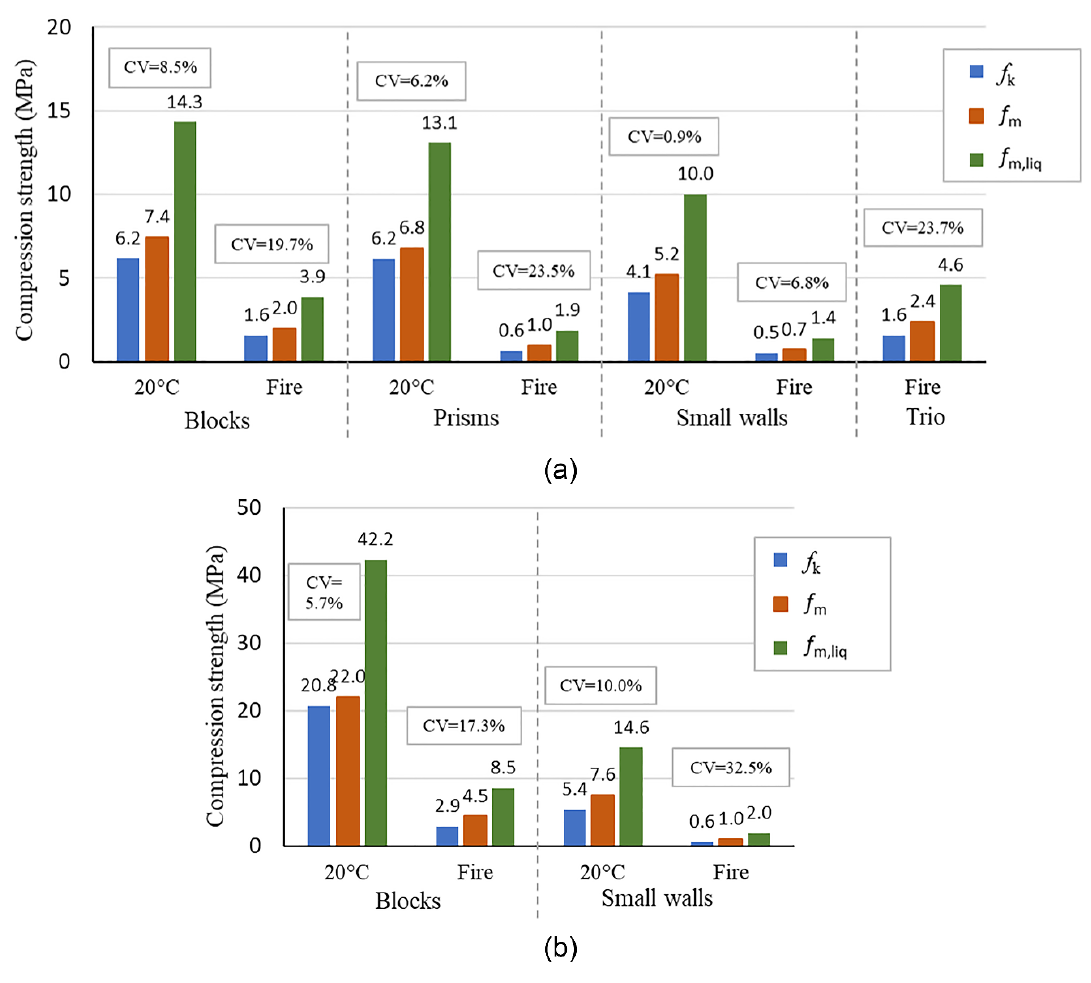
Figure 12. Compressive strength before and after fire: (a) 4 MPa blocks and (b) 10 MPa blocks (nominal).